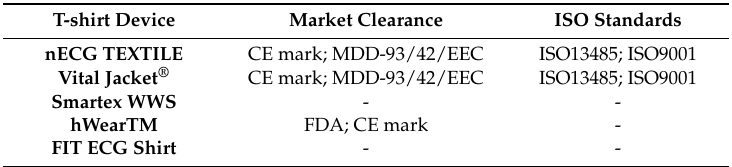
Table 3. MARKET CLEARANCE AND ISO STANDARDS OF EACH T-SHIRT DEVICE